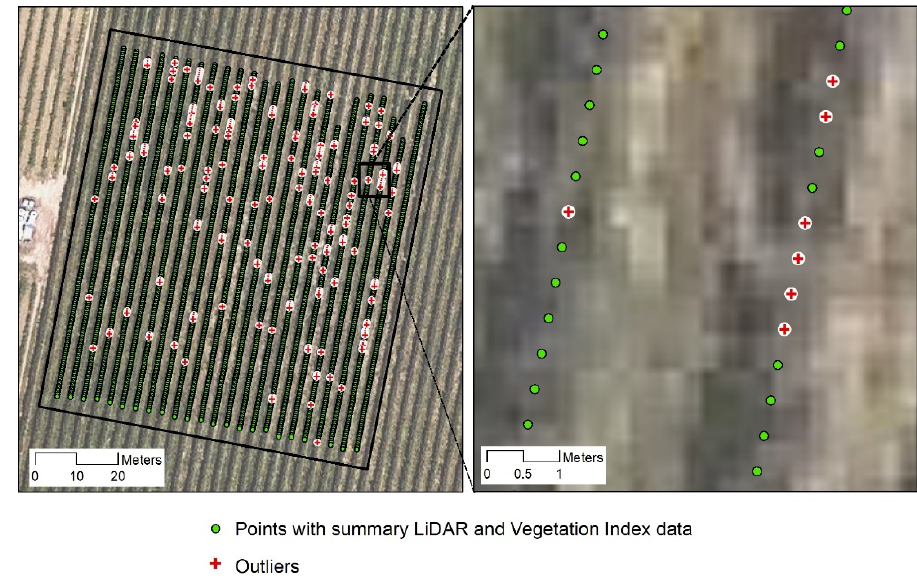
Figure 5. Point datasets representing ROI-B centroids and the ones eliminated in the cleaning process (outliers). Points are separated by a distance of 0.5 m along the almond tree rows. From the cleaned set of points, block kriging with local variograms was applied. Ac ‐